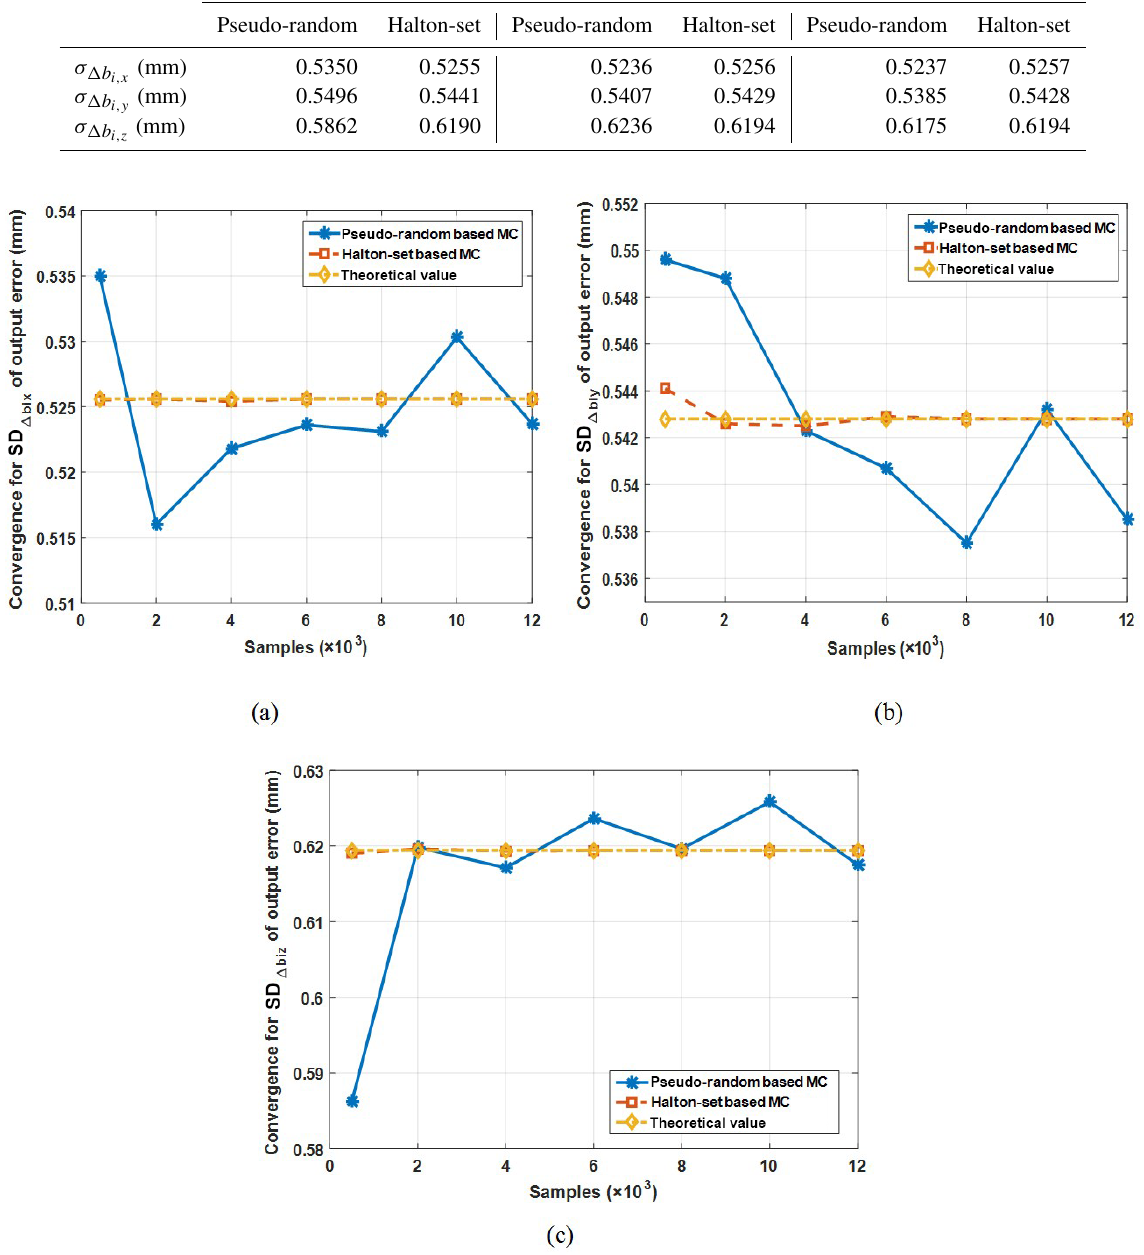
Figure 5. Convergence contrasts with pseudo-random and Halton-set based MC simulation for standard deviation of output errors for the L/R